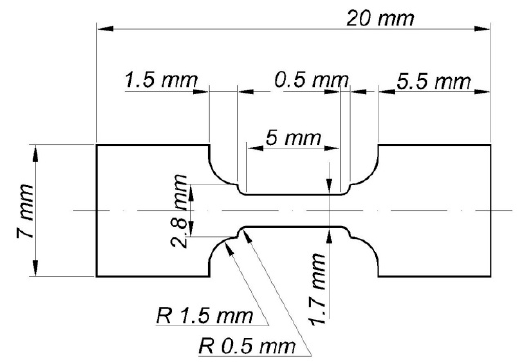
Figure 1. The geometry of the tensile-tested specimens.